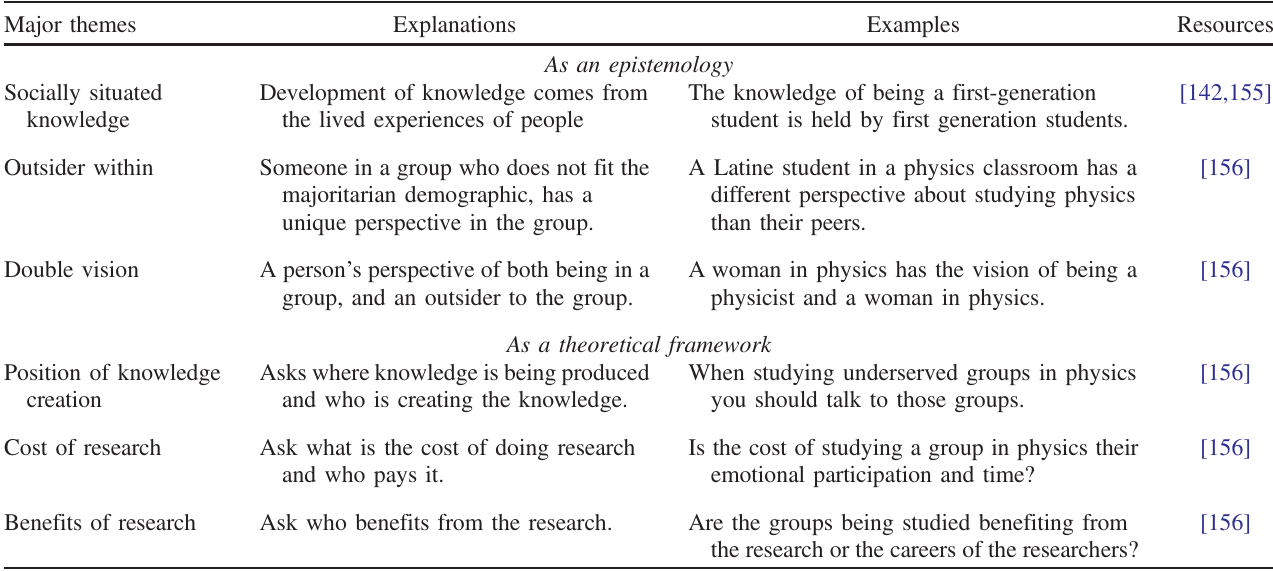
TABLE IV. Summary of standpoint